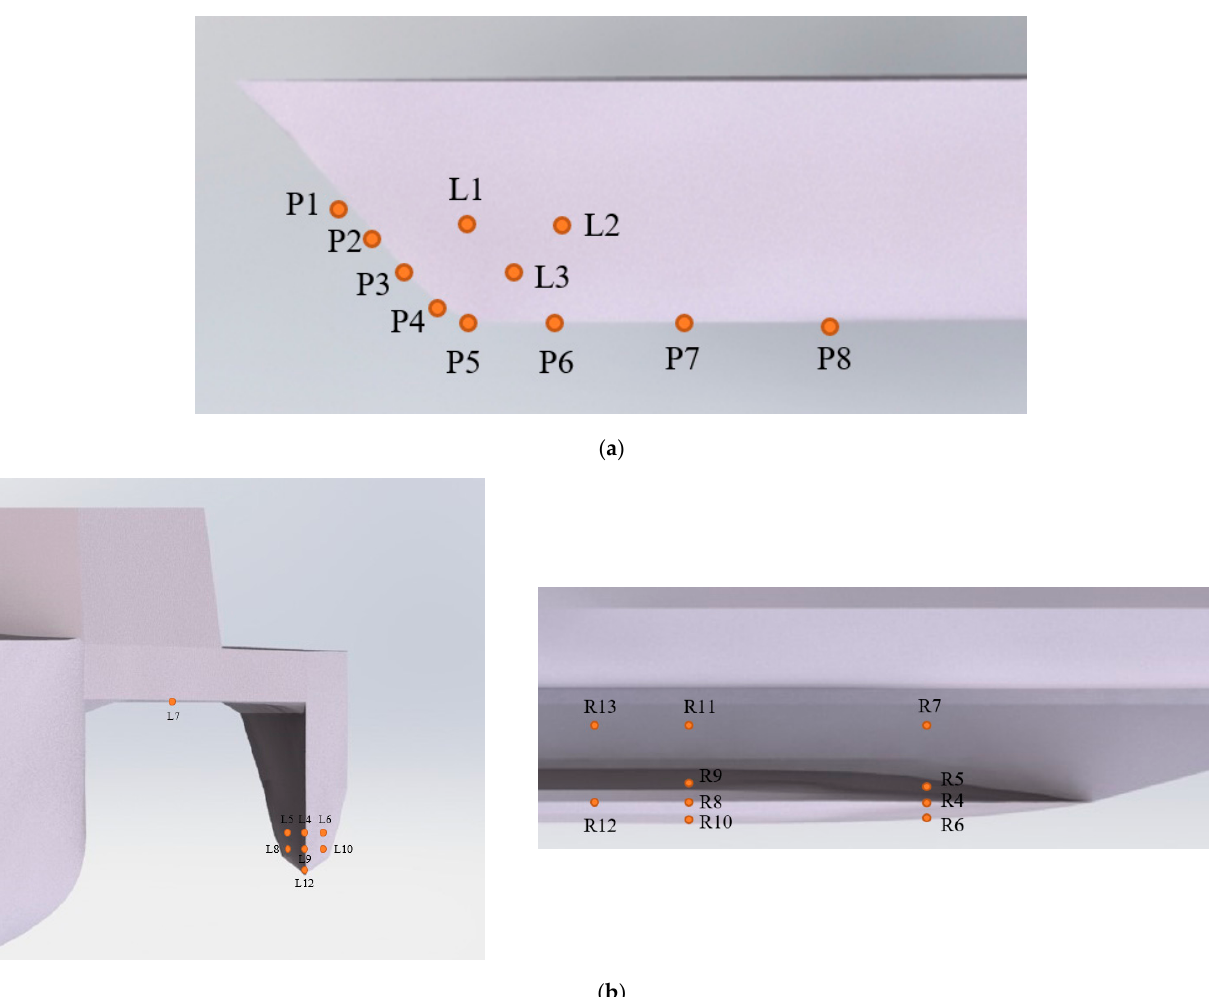
Figure 5. Monitoring points of slamming pressure. ( a ) Main hull; ( b ) Side hulls.